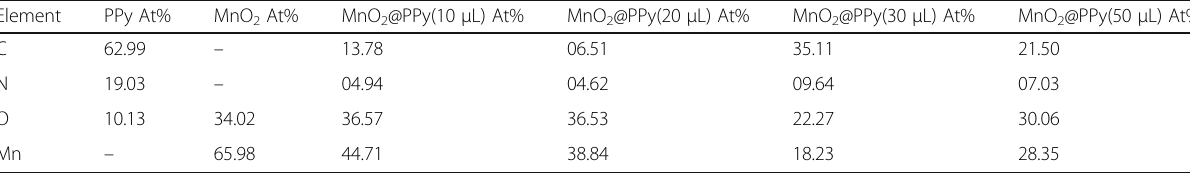
Table 1 EDX data for PPy, MnO 2 , and PPy-coated urchin-like MnO 2 sample